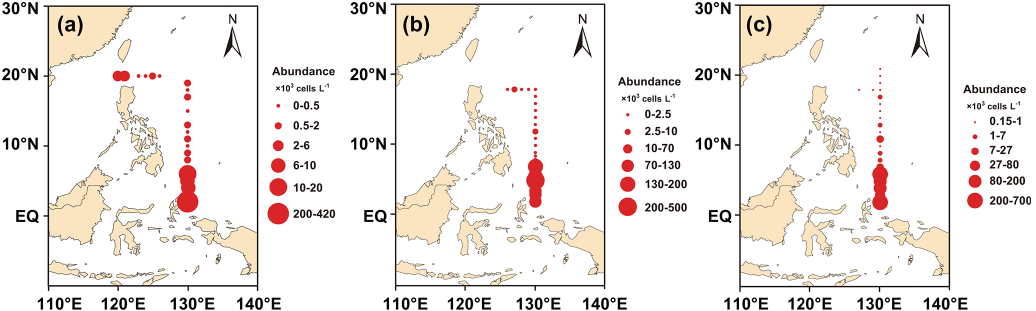
Figure 4. Horizontal distribution of phytoplankton abundance in the WPO: (a) surface layer in 2016, (b) surface layer in 2017, and (c) surface layer in